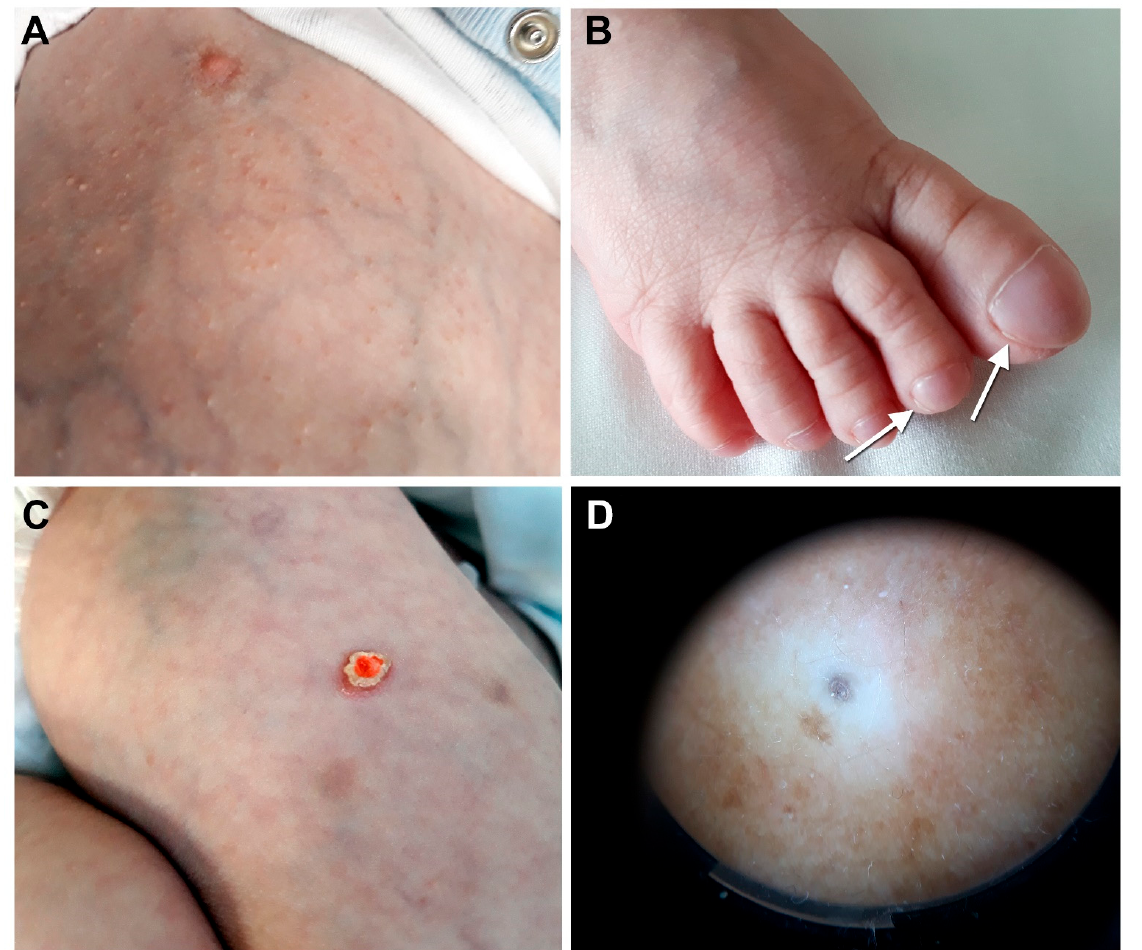
Figure 1. Patient’s clinical features at the age of 2 years. ( A ) Multiple whitish follicular papules on the abdomen, note the thin skin with prominent superficial veins related to liver disease and portal hypertension; ( B ) mild subungual hyperkeratosis (arrows) with nail clubbing and accentuated skin markings on the foot dorsum; ( C ) a single erythematous nodule surmounted by a thick scale is visible on the right thigh; the central red color is due to an antiseptic solution; ( D ) dermoscopy of a trunk papule shows follicular plugging surrounded by diffuse fine whitish scales.